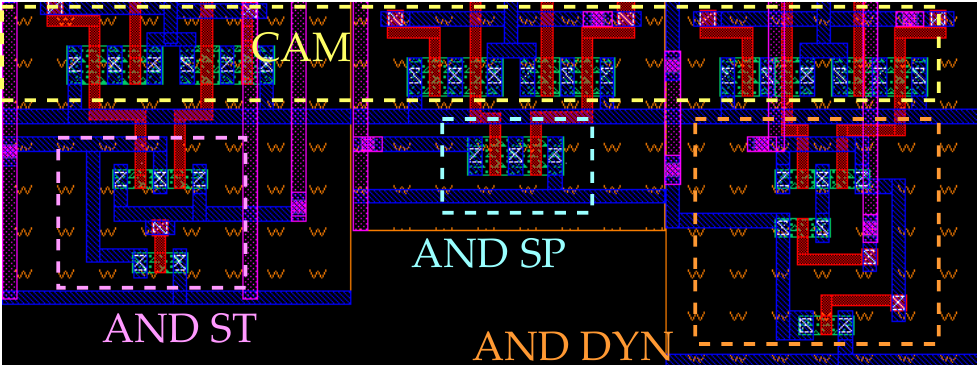
Figure 21. Layout bottom sections of static, special-purpose and dynamic AND cells.